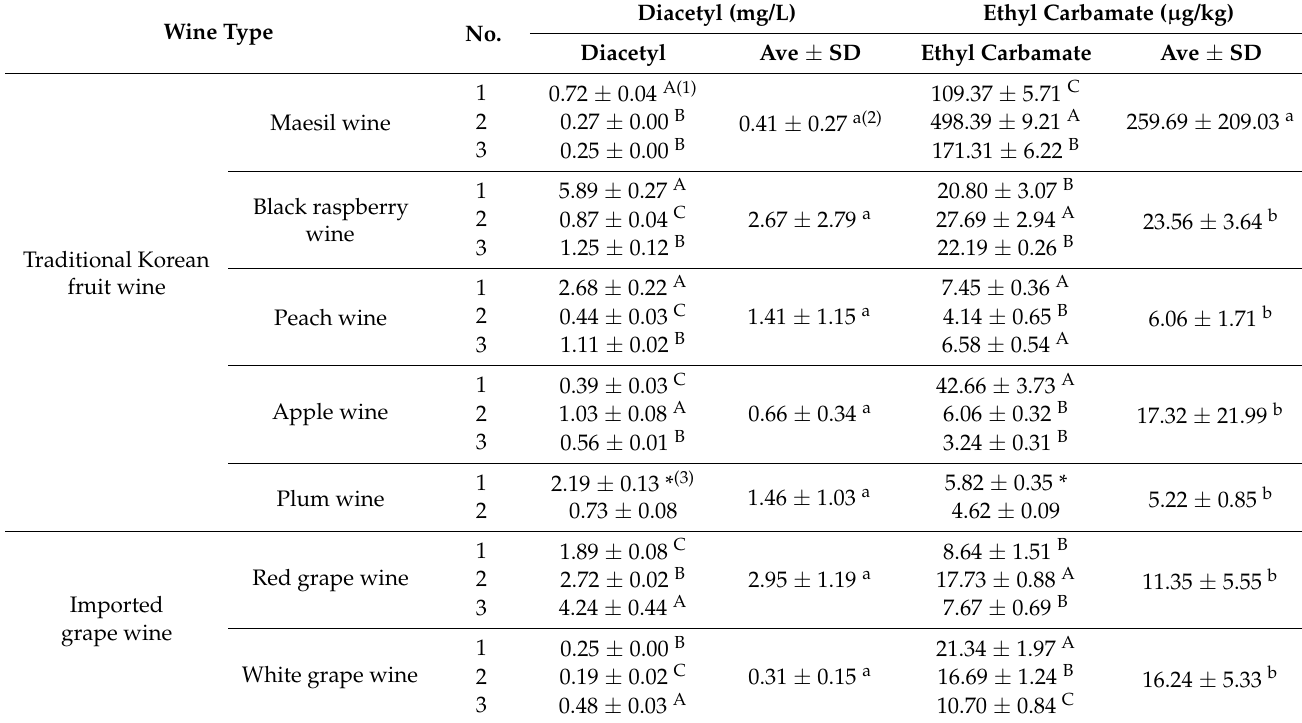
Table 4. The contents of diacetyl and ethyl carbamate in fruit